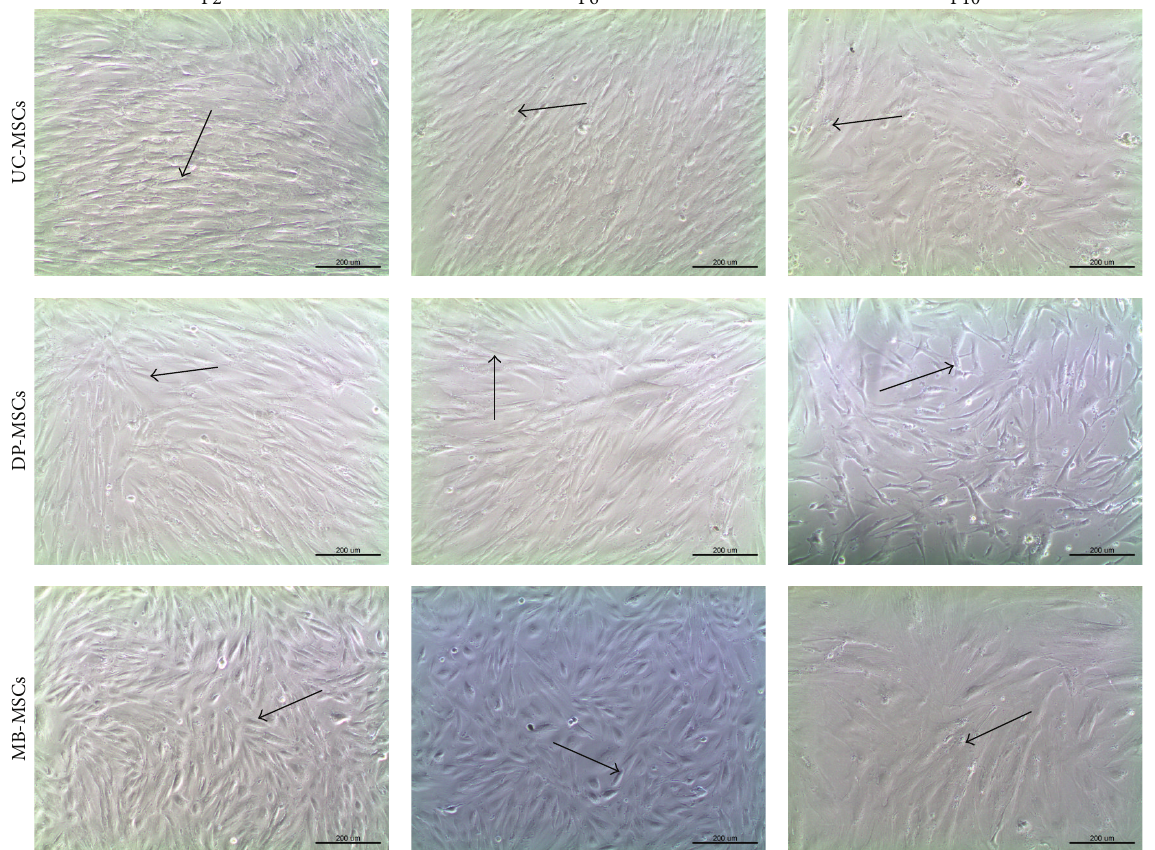
Figure 1: Morphology of UC-, DP-, and MB-MSCs (P2, P6, and P10) (100x). All MSCs exhibited a spindle-shaped morphology at P2 (arrow). However, MB-MSCs gradually became flatted and fragmented at P6 and P10 (arrow); a polygonal shape and cytoplasmic granulations were observed in UC-MSCs at P10 (arrow). A fibroblast-like morphology was maintained in DP-MSCs even at P10 (arrow). UC-MSCs: umbilical cord mesenchymal stem cells; DP-MSCs: dental pulp mesenchymal stem cells; MB-MSCs: menstrual blood mesenchymal stem cells; P: